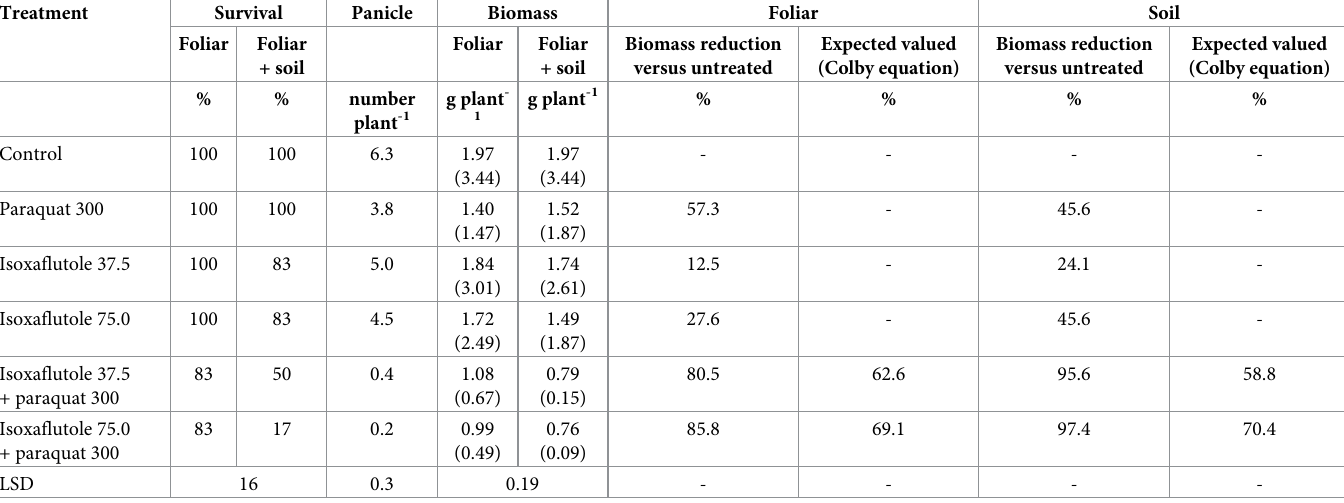
Table 6. Effect of herbicide treatments and type of uptake on survival, panicle production, and shoot biomass of glyphosate-resistant Chloris virgata . Percent bio- mass reduction and expected Colby equation values from mixtures of isoxaflutole and paraquat were also calculated. Herbicides were sprayed at the 40–50 leaf stage.